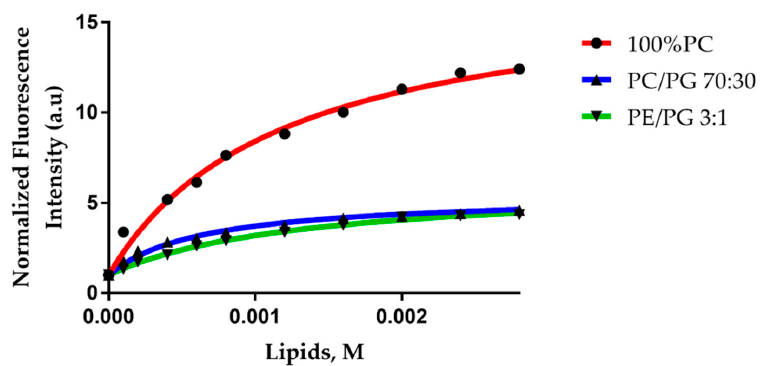
Figure 6. Binding isotherms for Trematocine interacting with LUVs of different compositions. Tryptophan fluorescence was measured. Trematocine concentration was 1 µM. Table 1. Partition constant values relative to the di ff erent LUV compositions. Table 2. Stern–Volmer constant relative to Trematocine in the presence/absence of LUVs of different compositions. Net Accessibility Factor (NAF) is defined as in Equation (2).